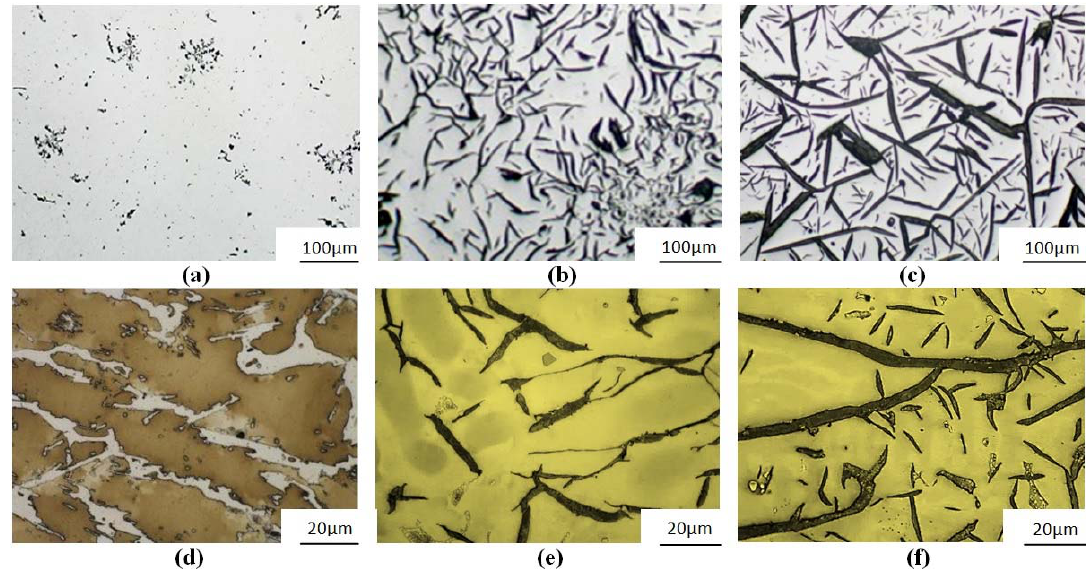
Figure 1. Austenitic cast iron Ni ‐ Mn ‐ Cu: ( a ) No. 1— trace amounts of nodular graphite ID8; ( b ) No.